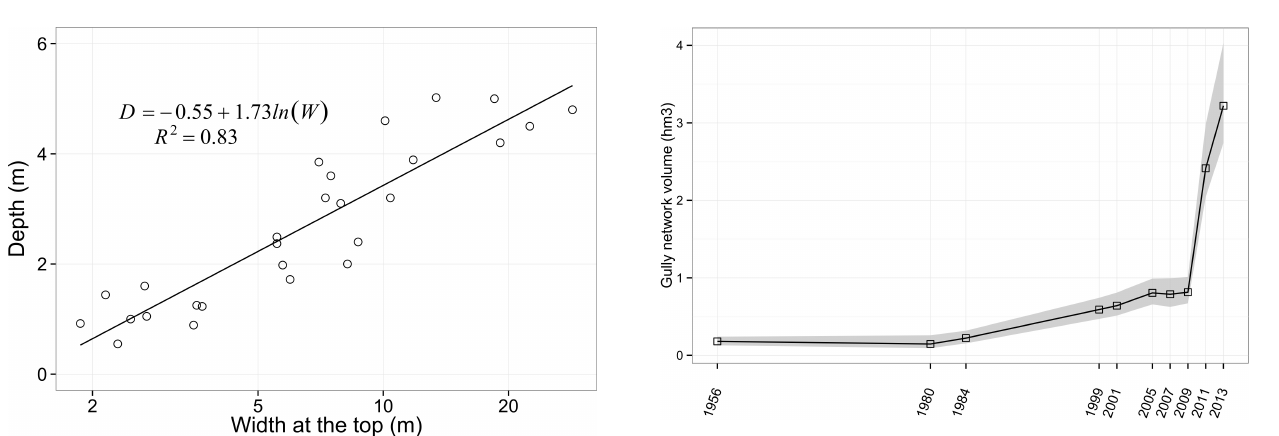
Figure 13. Width–depth relationship derived from field measure- ments.